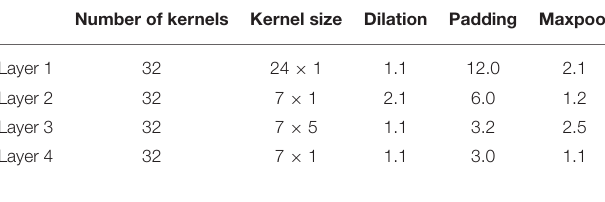
TABLE 3 | CNN parameters of the EEG subnetwork.